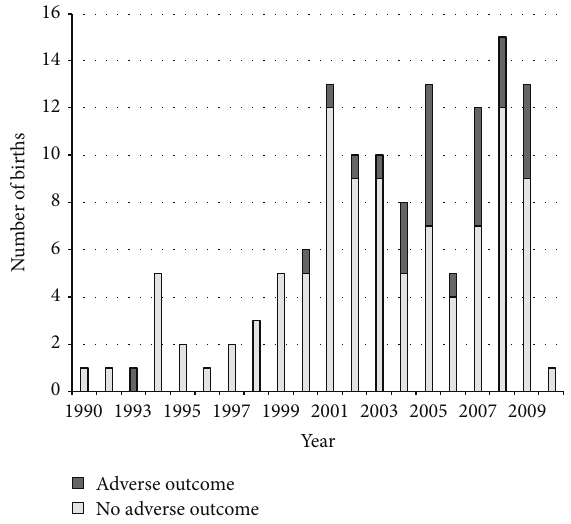
Figure 1: Distribution of obstetrical outcomes by year of